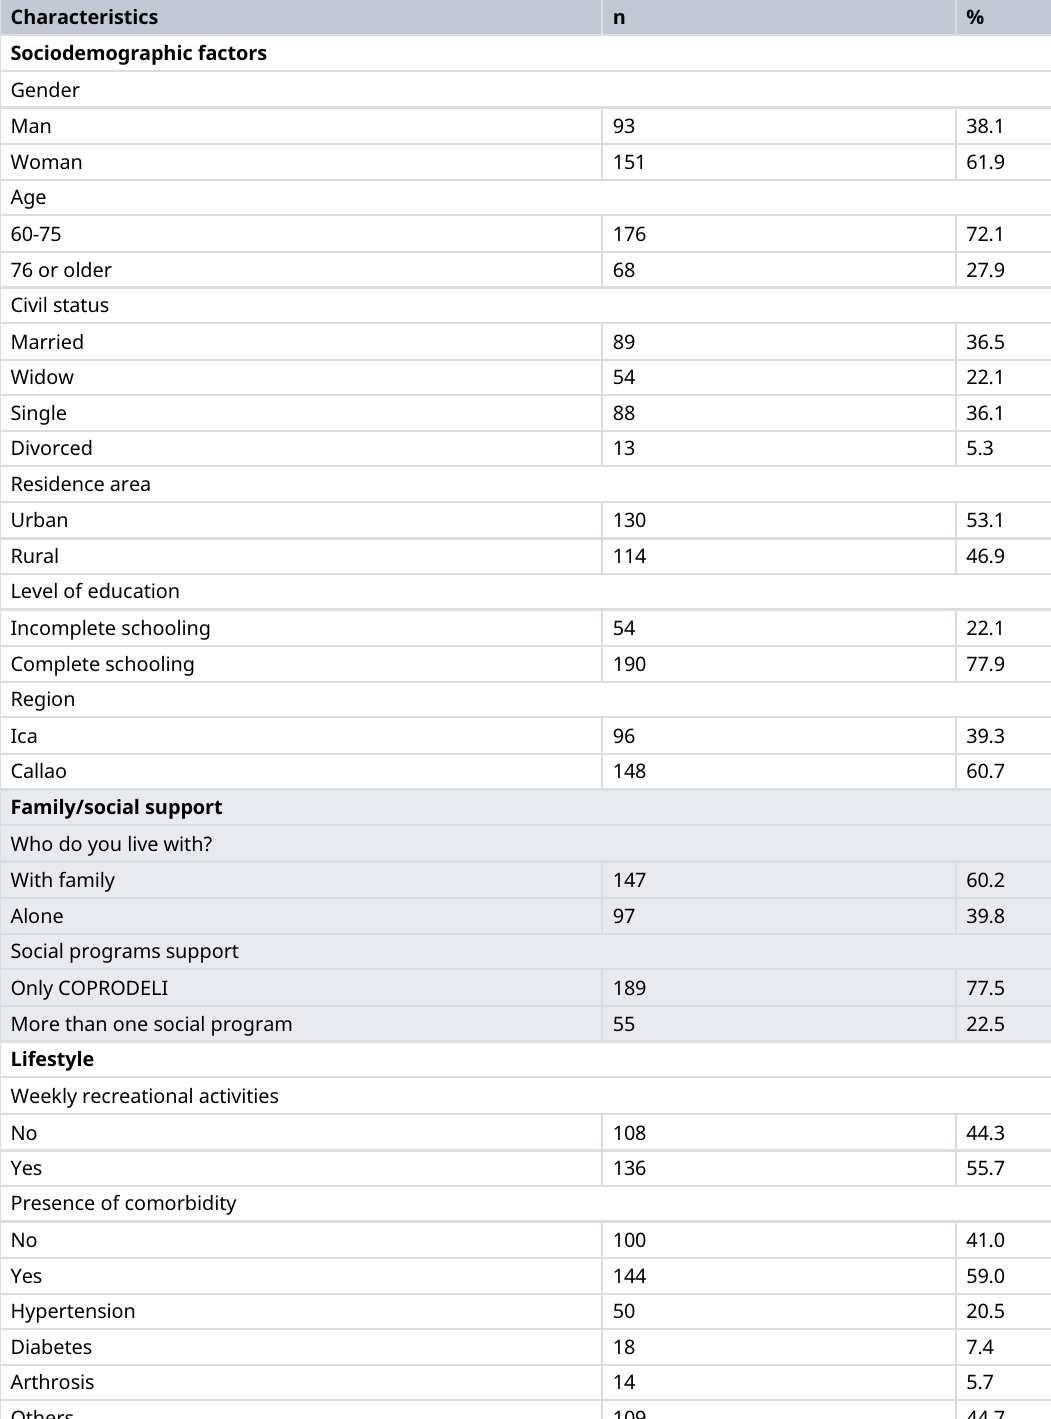
Table 1. Characteristics of older adults in the COPRODELI Social Program during the COVID-19 Pandemic, Peru. Characteristics n